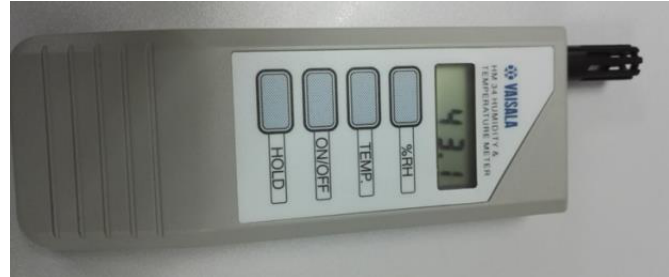
Figure 3. Standard temperature and humidity sensor.